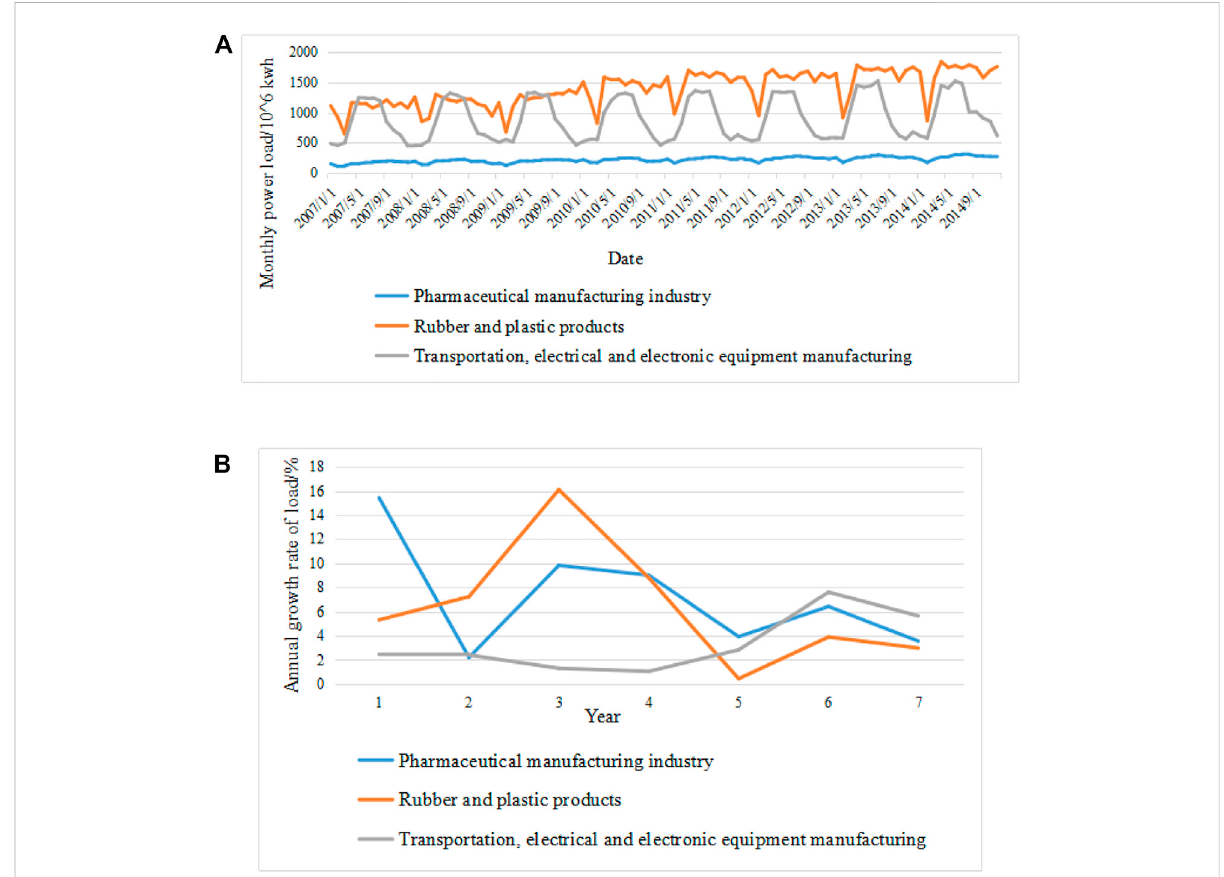
FIGURE 4 The input of LSTM: (A) monthly load curves for three industries, (B) Annual load growth curves for three industries.